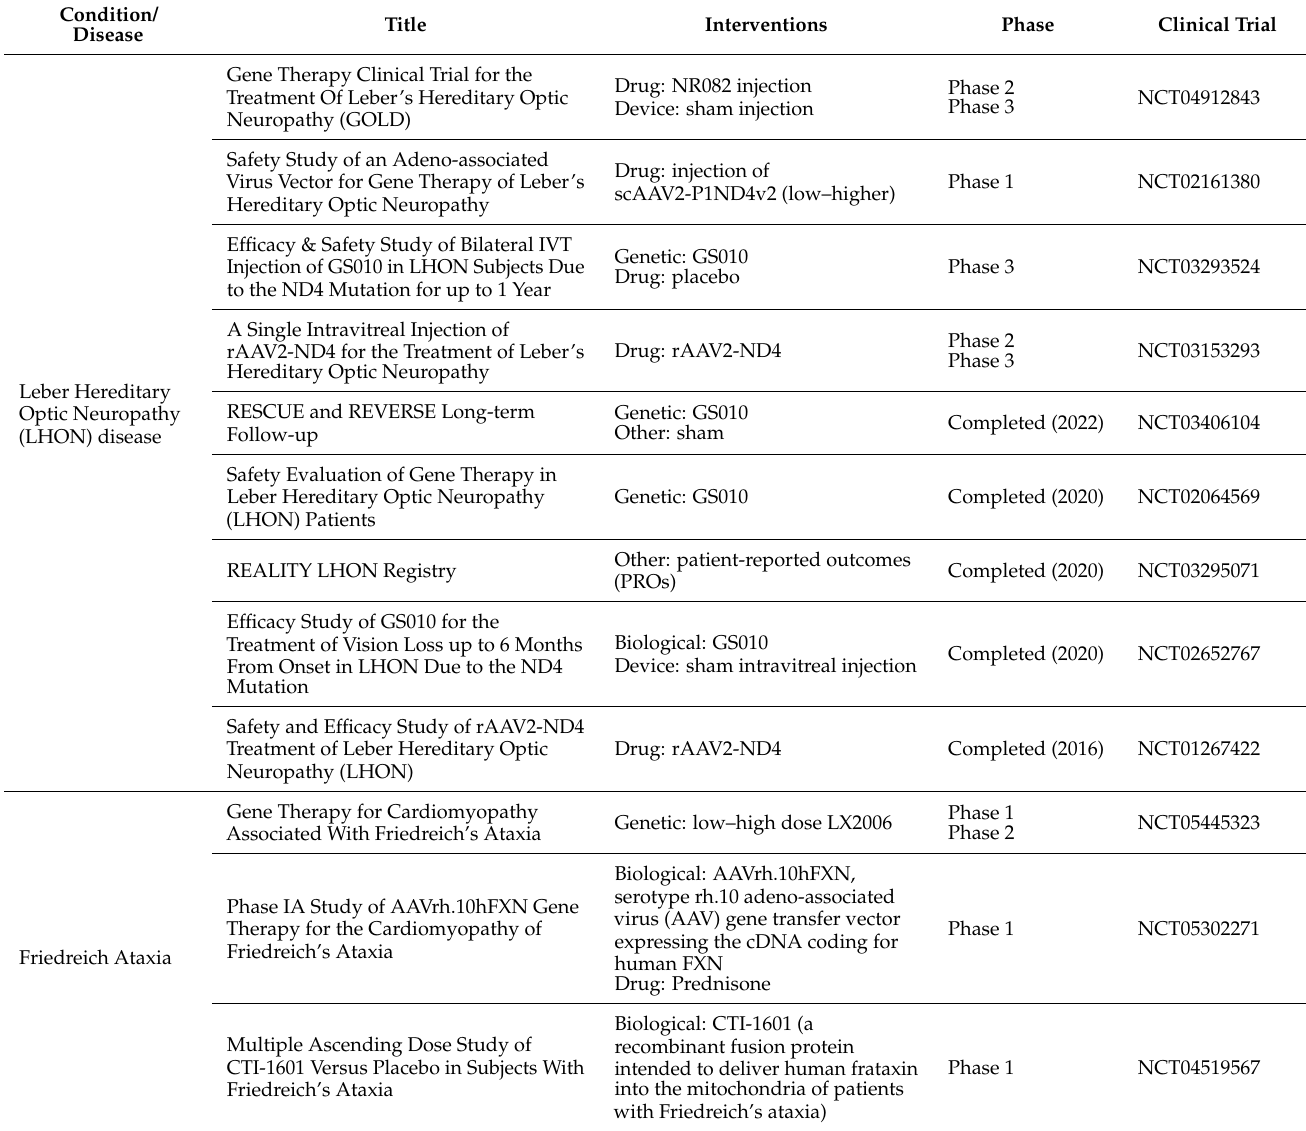
Table 2. Clinical trials using gene therapy or recombinant protein therapy and PRT for human severe genetic mitochondrial disorders, according to